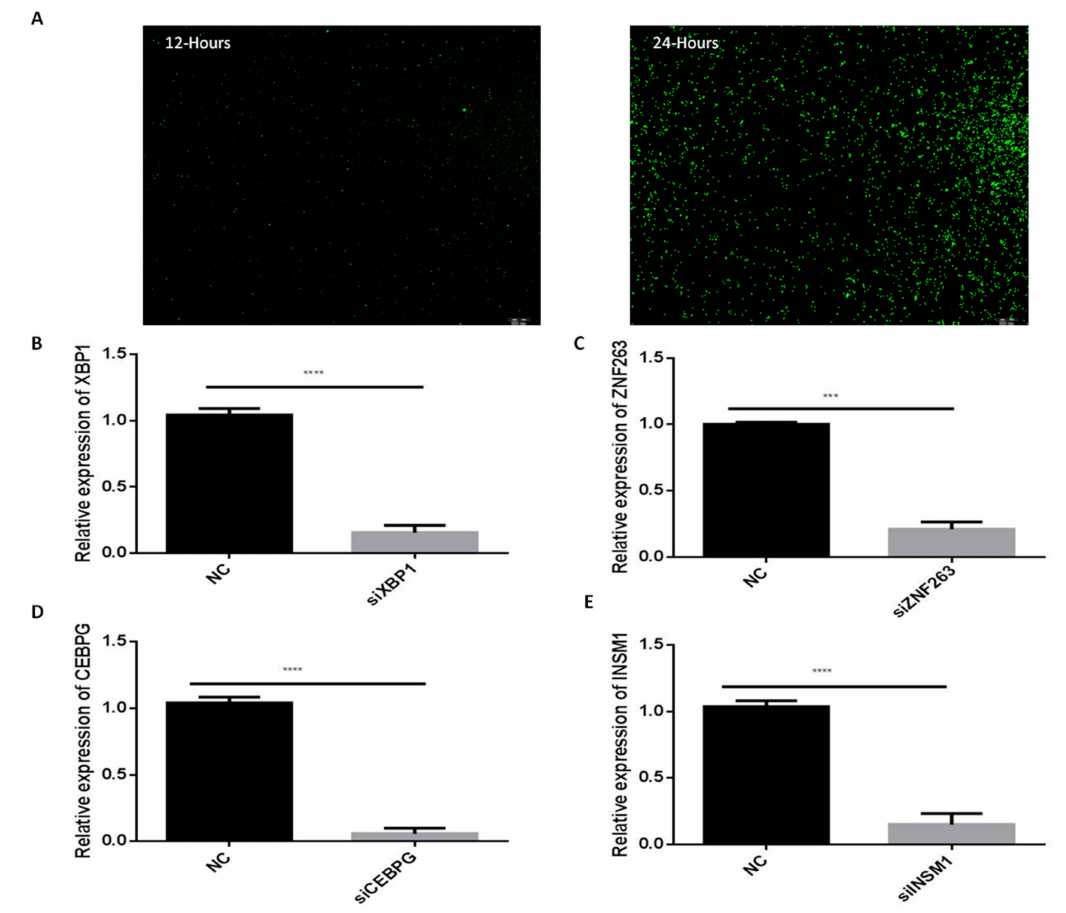
Figure 7. Transfection and interference e ffi ciencies of siRNAs. ( A ) FAM-labeled siRNA (NC). FAM-Labeled siRNA-NC was transfected into bovine adipocytes and transfection was checked after 6, 12 and 24 h intervals. Pictures were captured though an Olympus IX71 microscope (OLYMPUS). ( B , E ) the transcription factors XBP1 , ZNF263 , C / BEP γ , and INSM1 were down-regulated through small interference RNA (siRNA). The β -actin was as a housekeeping gene. Relative mRNA expression levels were normalized with NC. The values represent mean ± SEM ( n = 3). * p < 0.05; *** p < 0.01; and **** p <